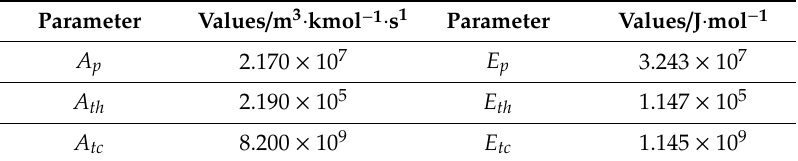
Table 1. Kinetic parameters values for styrene polymerization ( K = Ae − E / RT